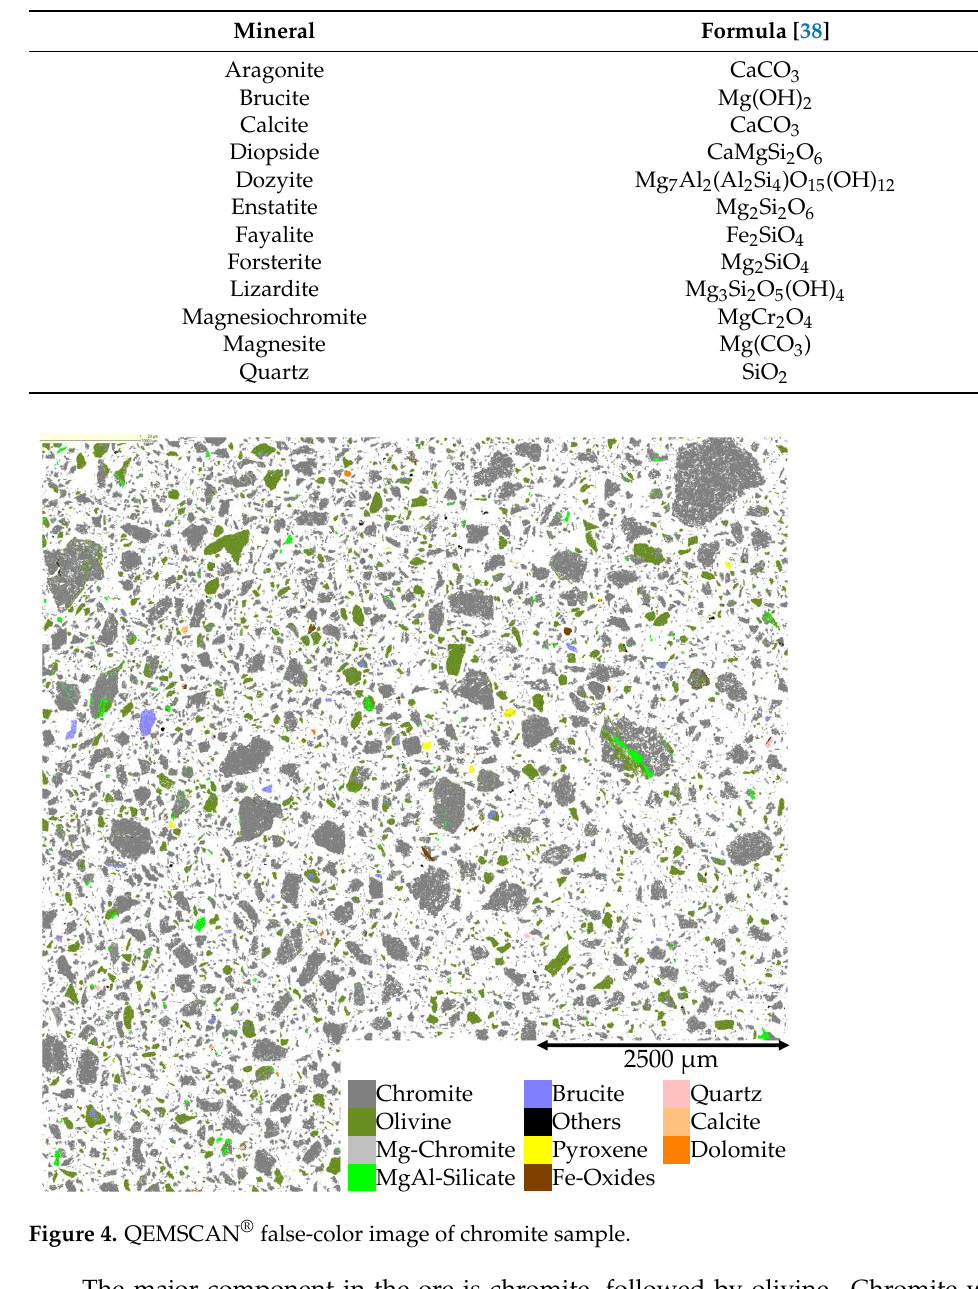
Table 1. Minerals identified by Raman microscopy.